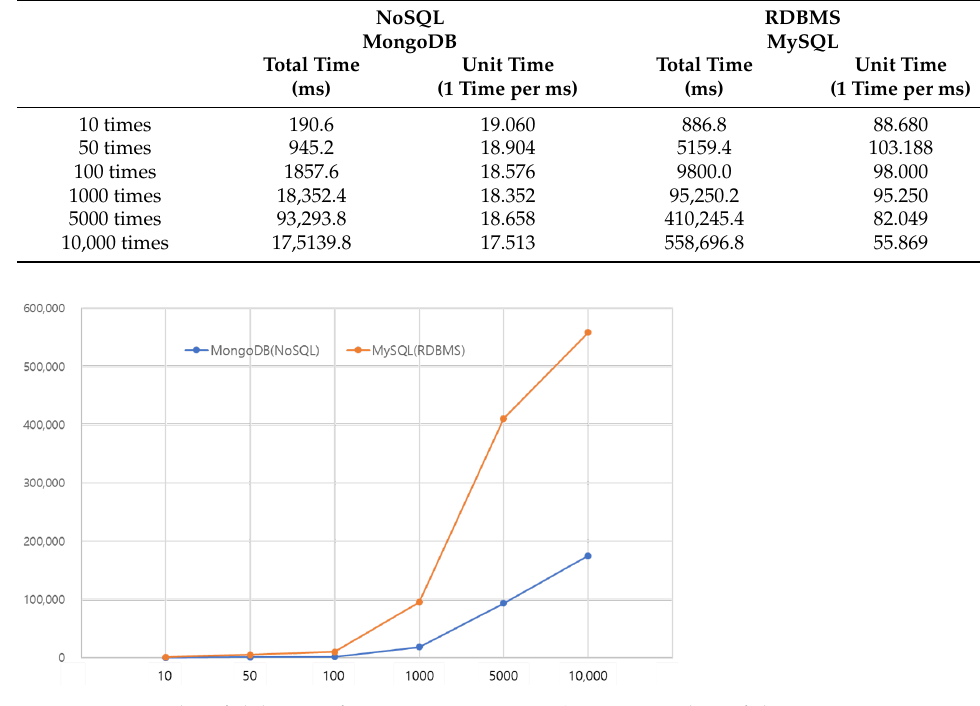
Figure 13. Results of delete performance experiment ( x -axis: number of data points, y -axis: read speed in